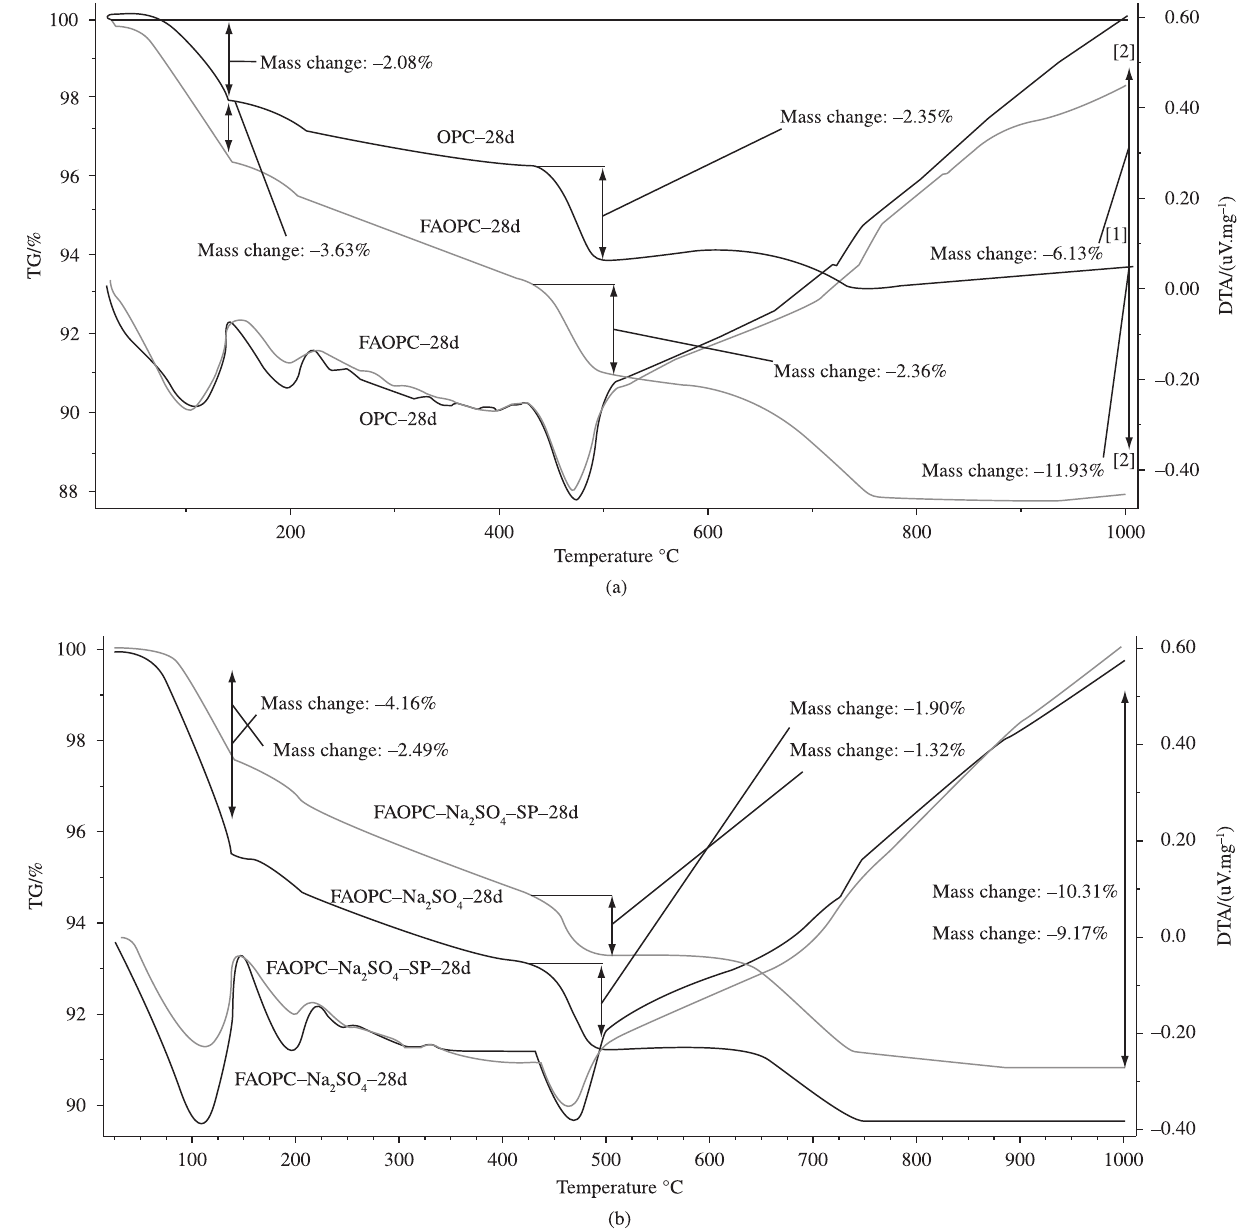
Figure 9. DTA curves of 28 days hydrated